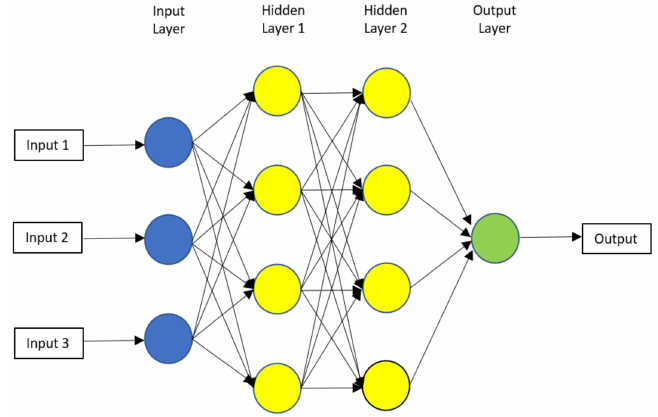
Figure 1. Example of a NN with 2 hidden layers and multiple